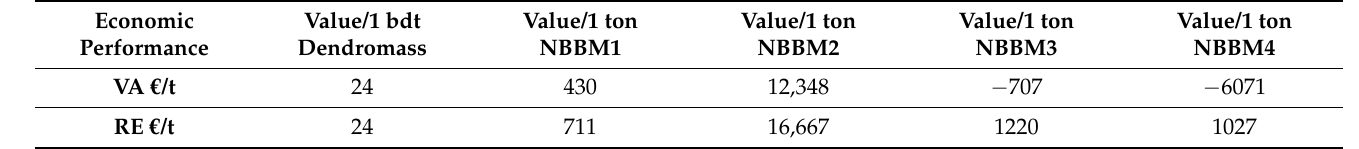
Table 3. Product system value of the dendromass production and NBBM1–4 per ton of